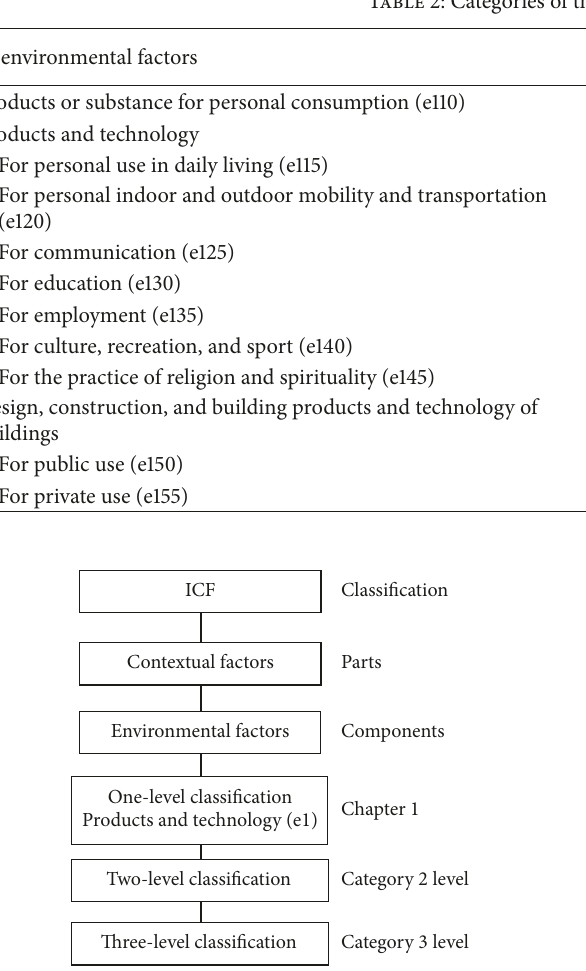
Figure 1: AT checklist based on the ICF framework